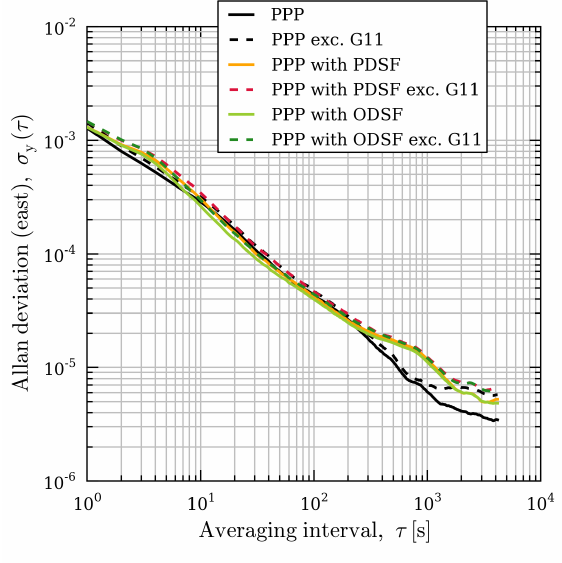
Figure 8: Allan deviation plots of the corresponding easting posi- tion time series at station UCL between 15:17 and 21:04 on August 31 2013 shown in Fig. 6.